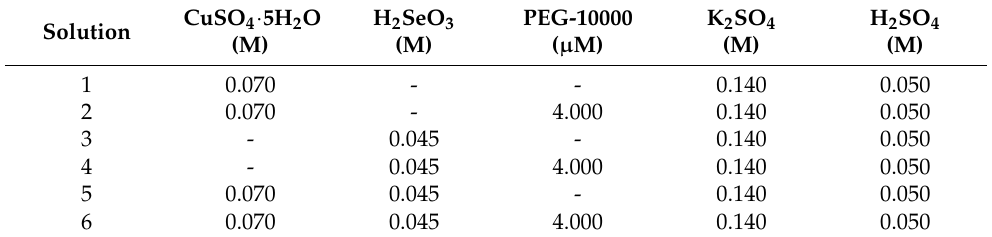
Table 1. Solution composition of electrochemical measurement and